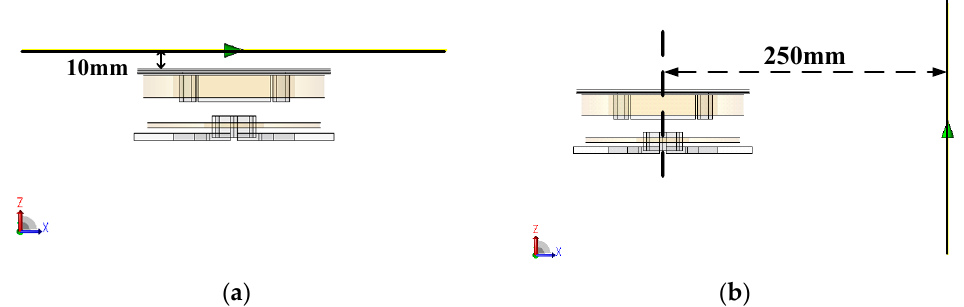
Figure 7. Schematic diagram of simulated measurement position. ( a ) Radial position 10 mm above the receiving coil. ( b ) Axial position 250 mm outside the magnetic coupler.